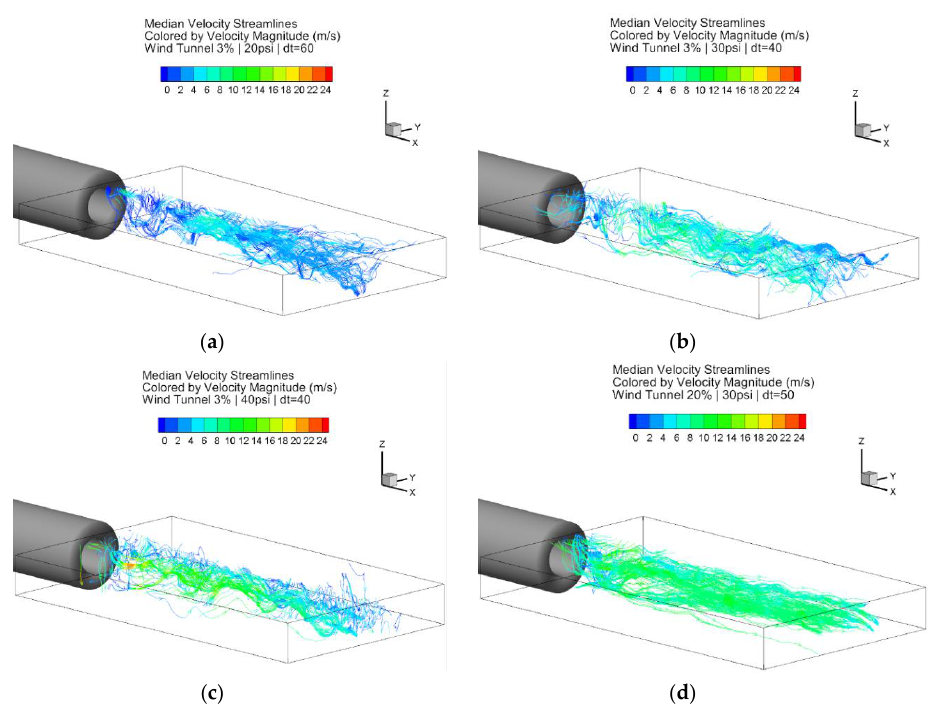
Figure 14. Instantaneous streamlines for freestream and vortex settings of 3% and 20 psi ( a ), 3% and 30 psi ( b ), 3% and 40 psi ( c ), and 20% and 30 psi ( d ).